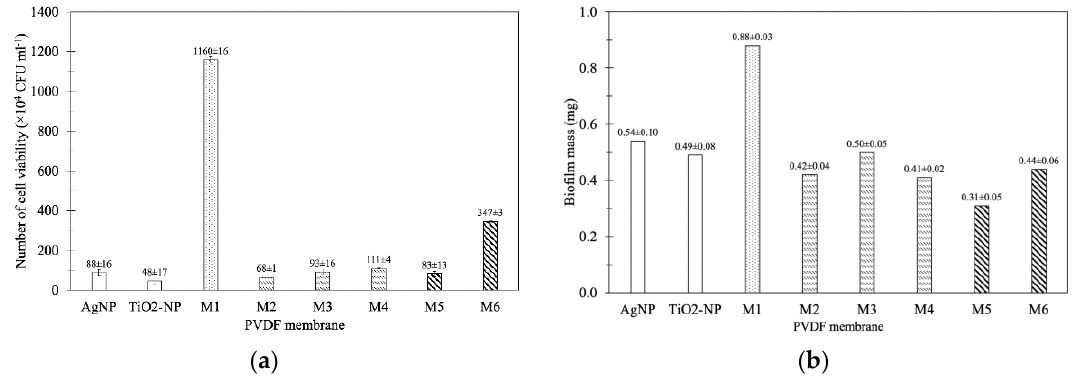
Figure 8. Antibacterial properties and biofilm inhibition test of membranes: ( a ) the number of viable E. coli cells and ( b ) biofilm formation on membranes.